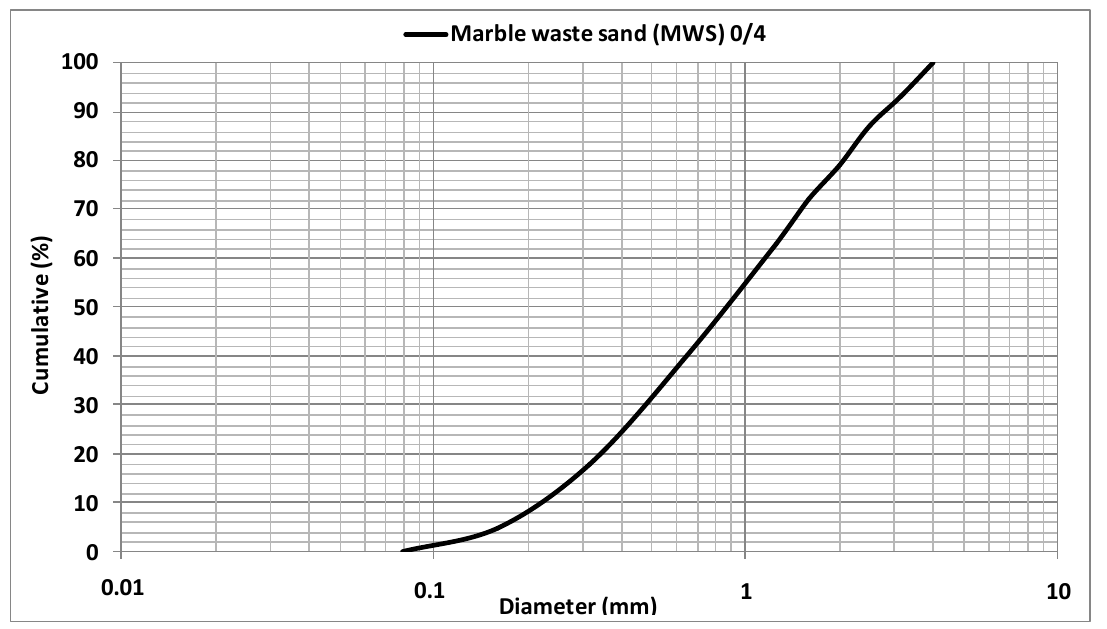
Figure 4. Particle size distribution curve of marble waste sand MWS.